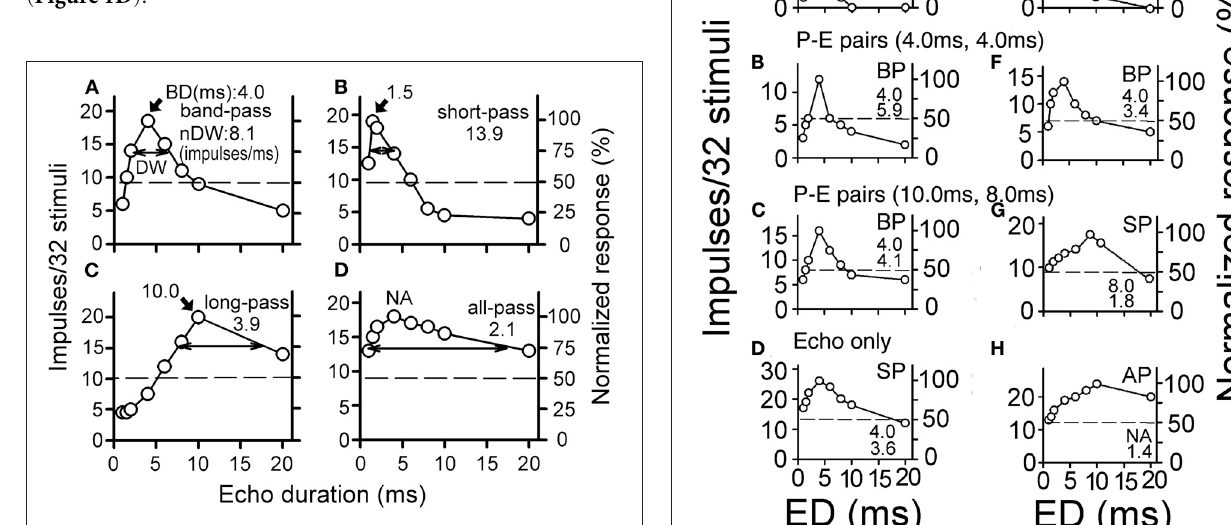
FIGURE 2 | (A–H) The echo duration tuning curves of two collicular neurons determined with the echo pulses of three pulse-echo (P-E) pairs and with single pulses. The type of duration tuning curve, the BD and the nDW are shown within each plot. Note that the nDW progressively decreases with lengthening of PD and P-E gap of three P-E pairs [Adapted from Wu and Jen